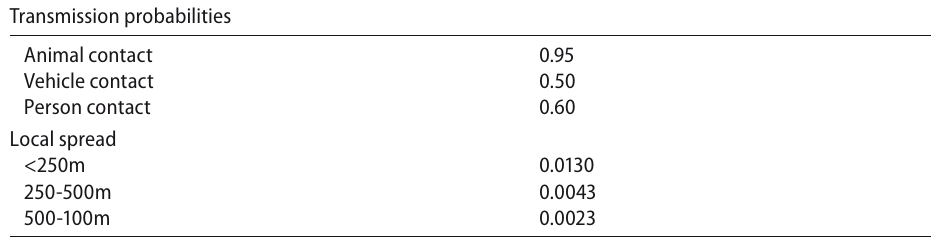
Transmission probabilities for the different contact types and local spread within the simulation model